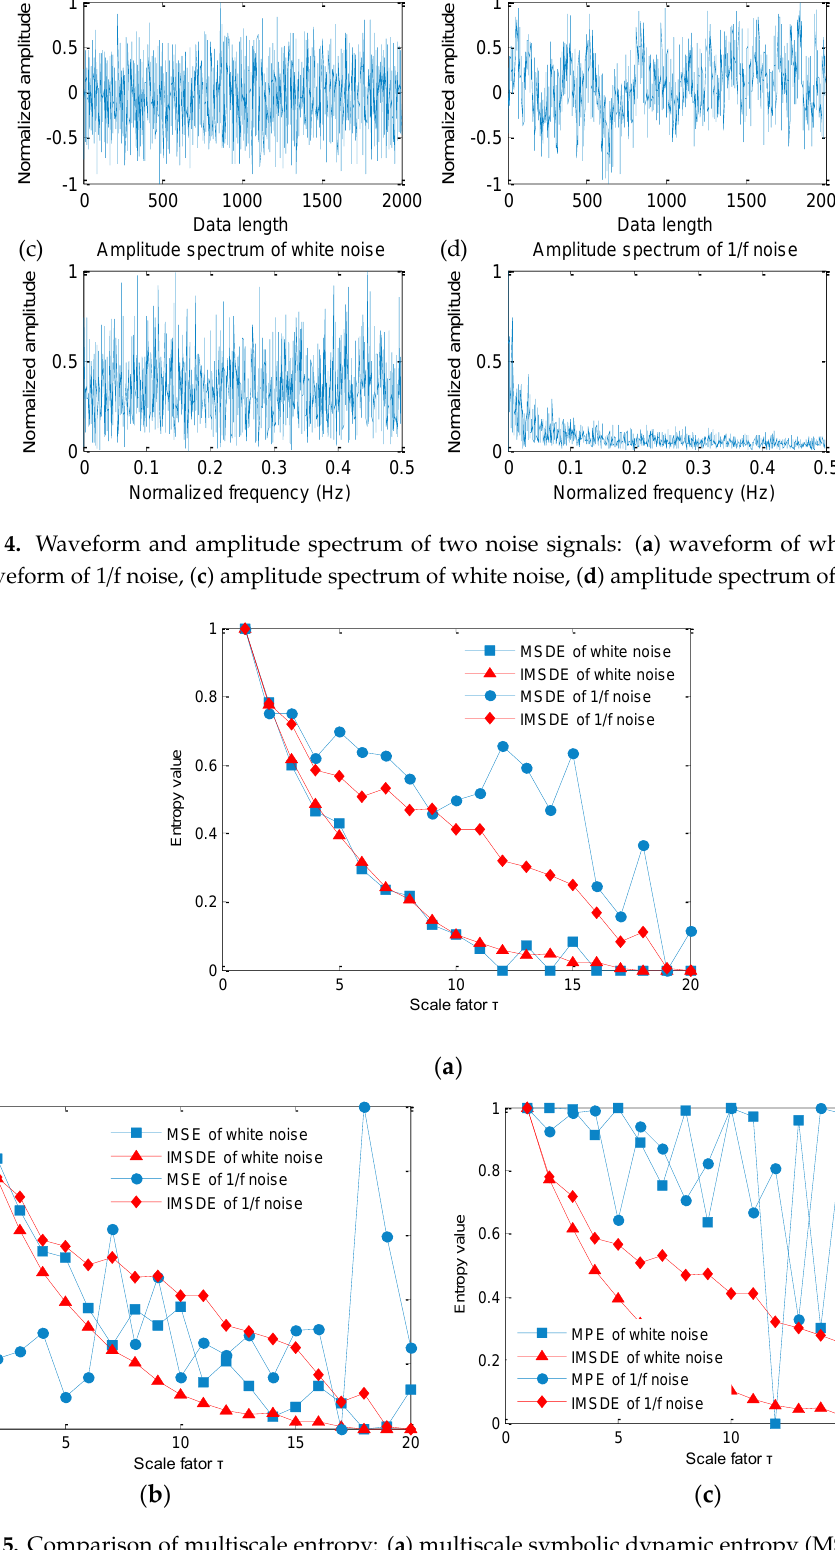
( b ) Figure 6. IMSDE of two noises for different data length: ( a ) IMSDE of white noise and ( b ) IMSDE of 1/f noise. ( a ) ( b ) Figure 7. IMSDE of two noises for different symbols: ( a ) IMSDE of white noise and ( b ) IMSDE of 1/f noise. 2.3. Fault Pattern Recognition According to the routine diagnostic procedures, after bearing vibration signal preprocessing and fault feature extraction, an automatic identification process needs to be added in the proposed method. MRVM is a useful fault classification model, which has been proven to have advantages over